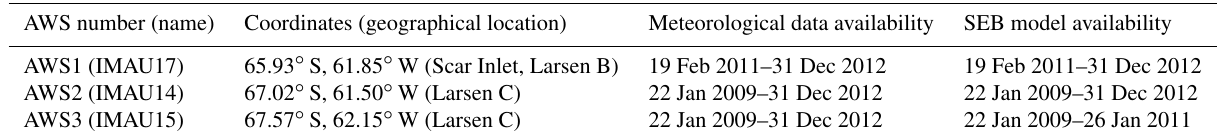
Table 1. The metadata for the AWS observations. In the current paper, the AWS locations are numbers, following Turton et al. (2018). We have also provided the name used in other studies in brackets.